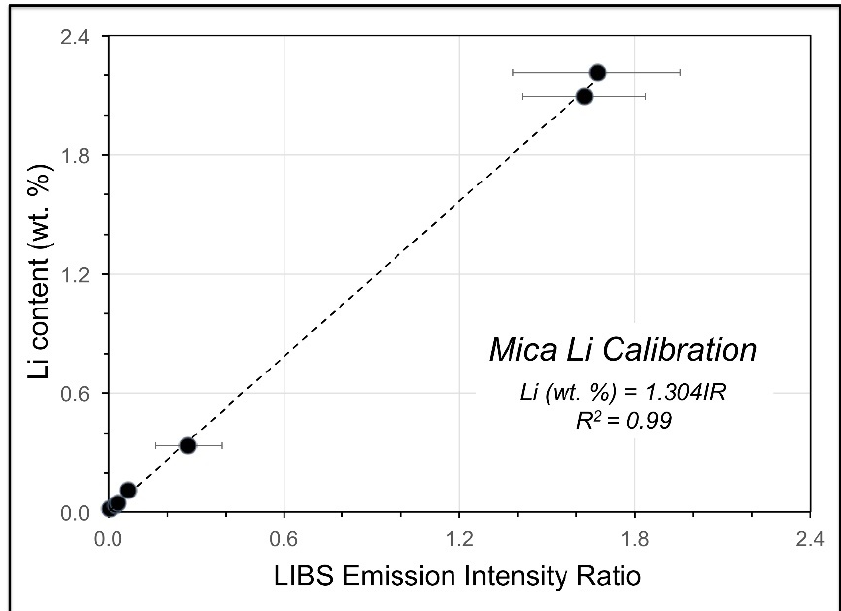
Figure 11. Handheld LIBS calibration curve for mica using the suite of nine mica specimens of known composition described in Appendix A.1. The RMSE of the calibration is 0.0204%.